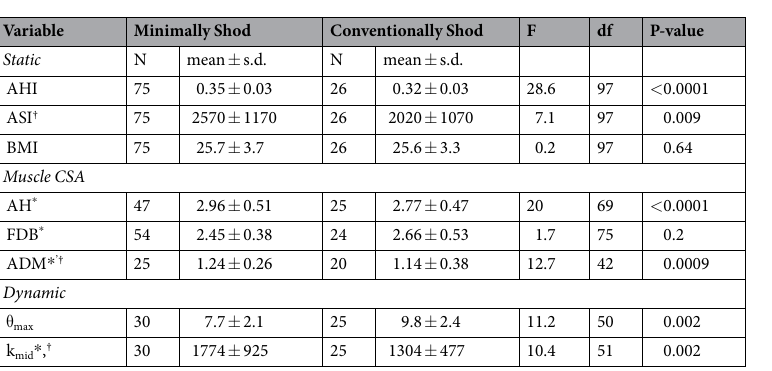
Table 1. Means and standard deviations of study variables, and results of ANOVA tests for differences between minimally- and conventionally-shod participants. Tests are carried out on variance from general linear models. * For general linear models, these variables were scaled by dividing by (body mass) 0.67 . † For general linear models, these variables were